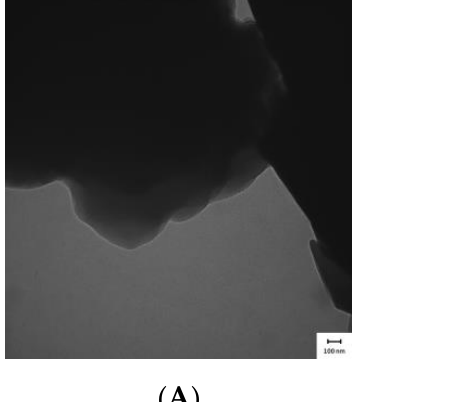
electron density, did not. In Zn-AlPO 4 , Zn(II) may have been homogeneously dispersed in